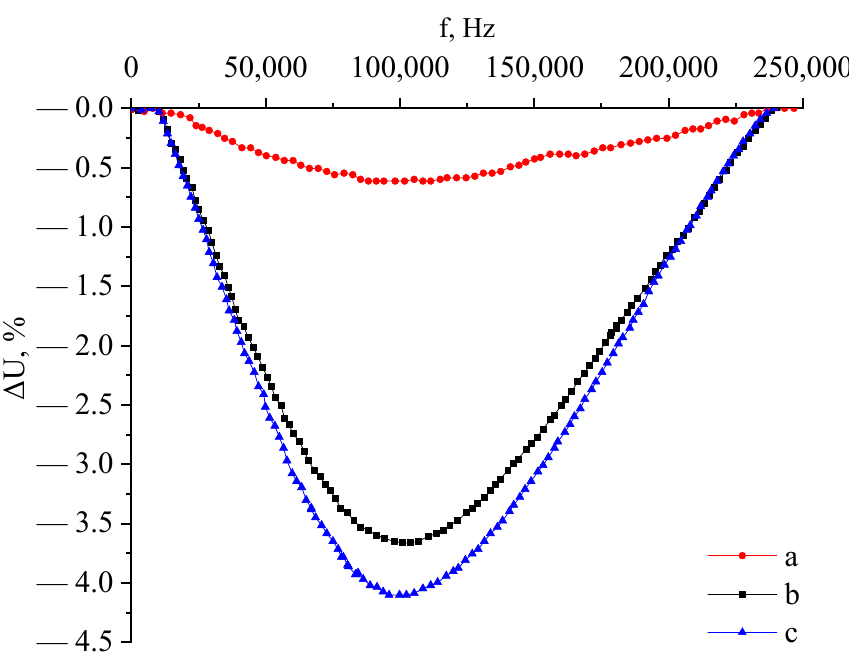
Figure 21. Graph of attenuation values for different frequencies: (a) ABE wires treated by sequential immersion in tetraethoxysilane and ammonia (five cycles); (b) ABE wires treated by immersion in SiO 2 nanoparticles sol (five cycles); (c) uncoated wires (control sample).